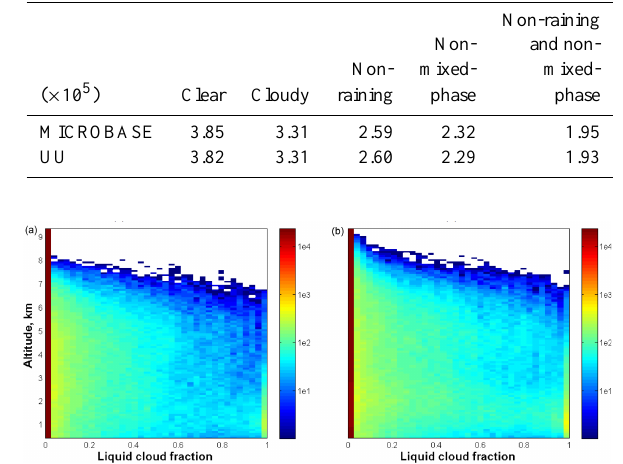
Fig. 2. Contour frequency by altitude diagrams (CFADs) of liquid cloud fraction from the 5-min MICROBASE and UU data for the period of 1998 to 2006. To avoid the artifact of very small cloud liquid water content (LWC) retrievals at high altitudes, the liquid cloud mask is defined as data points with LWC > 0 . 01gm − 3 .